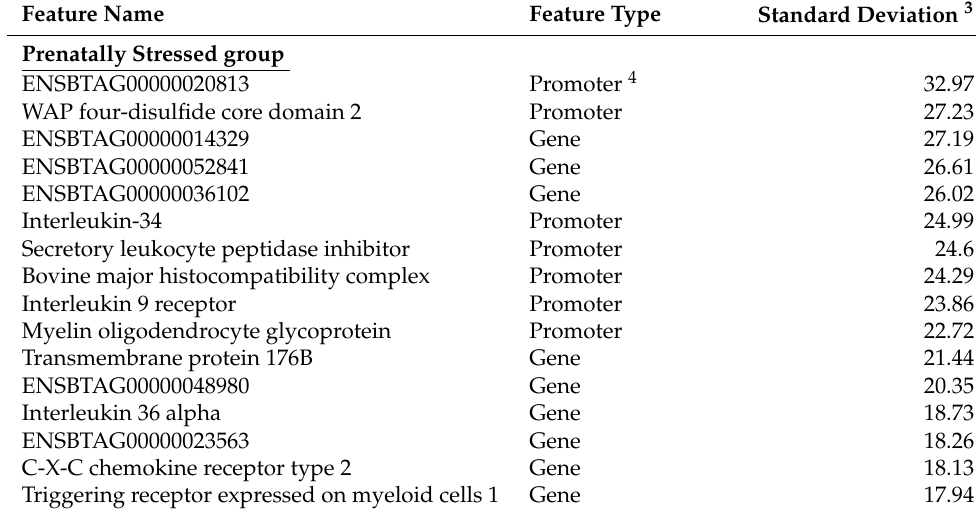
Table 5. Highly variable 1 genomic features involved in the immune response biological process 2